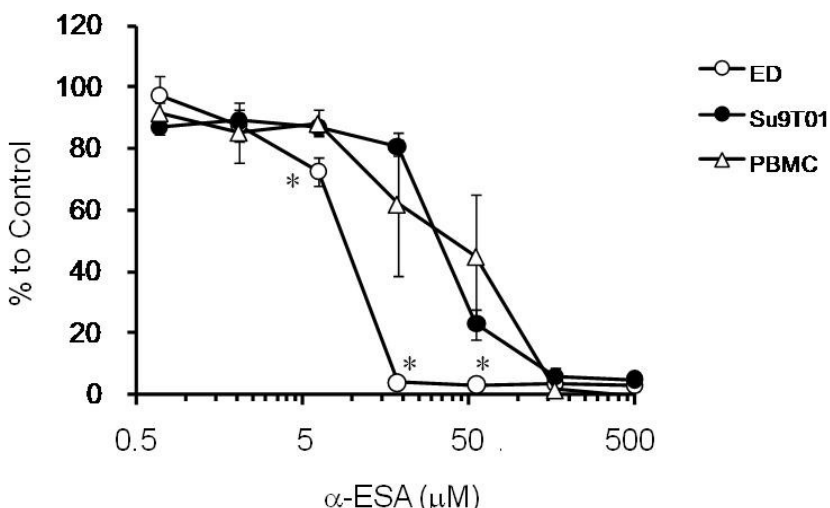
Figure 3. Effect of α-ESA on ATL cell and PBMC